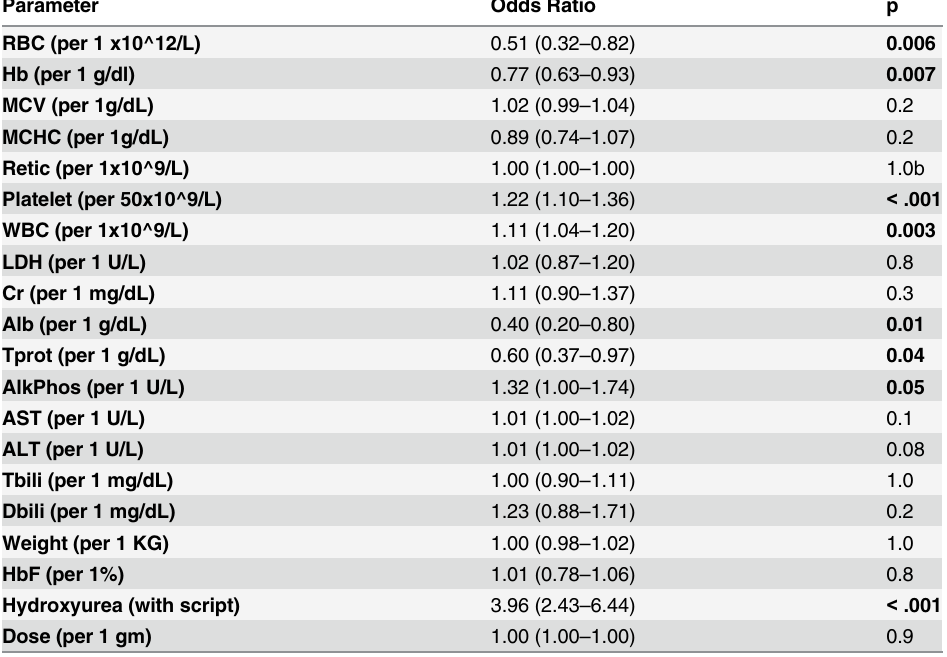
Table 2. Age adjusted odds ratios (OR, 95%CI) for steady state laboratory determinants for those with (cid:1) 6 ED visits.